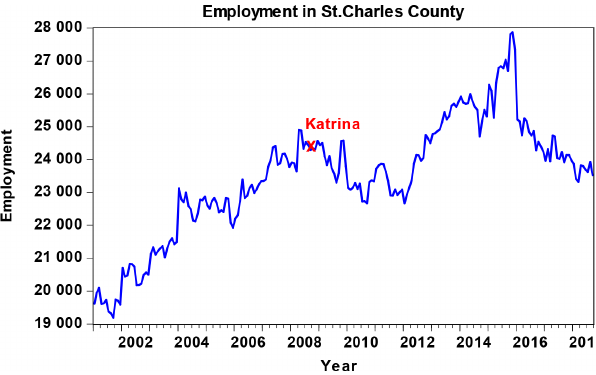
Figure 2. Monthly employment time series in St. Charles County before and after Hurricane